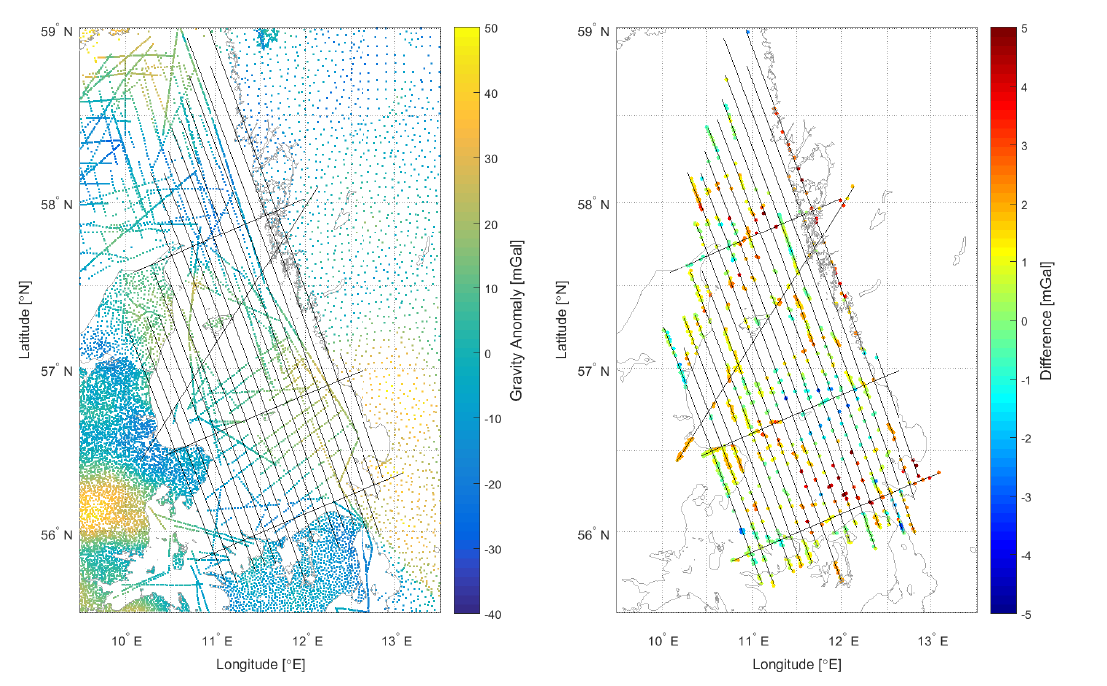
Figure A3. The NKG gravity database contains 16,125 observation points for the area shown in this figure. ( Left ) Gravity anomalies at the observation points. ( Right ) Differences between bias adjusted iMAR estimates and upward continued gravity points from the NKG